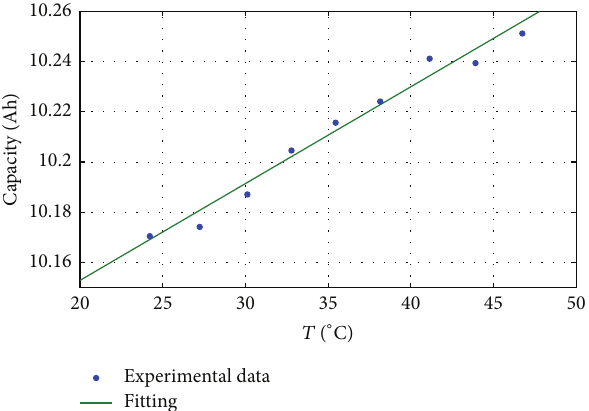
Figure 5: Battery capacity in function of the